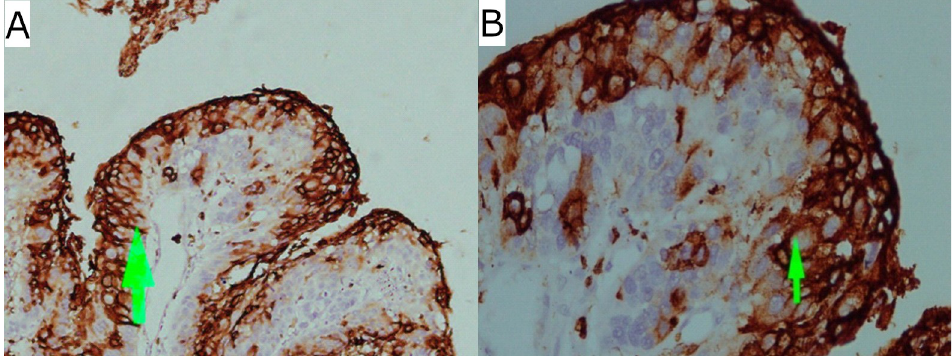
Fig 3. Immuno-histochemical expression of COX -2 in carcinoma in situ. Staining (membranous and cytoplasmic) in upper 2/3rd of mucosa (green arrow head) (A) at low power magnification (10x) (B) at high power magnification